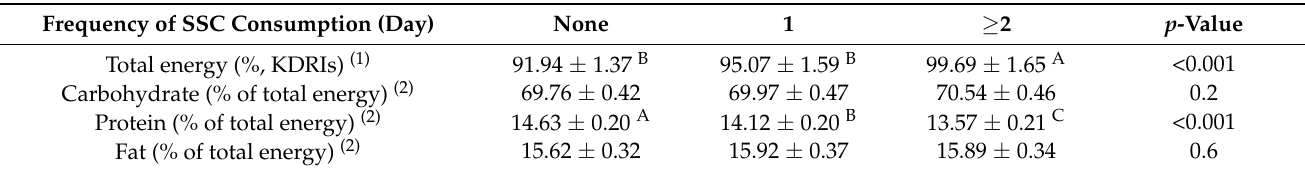
Table 2. Total energy and macronutrient intake values according to the frequency of sugar-sweetened coffee consumption.